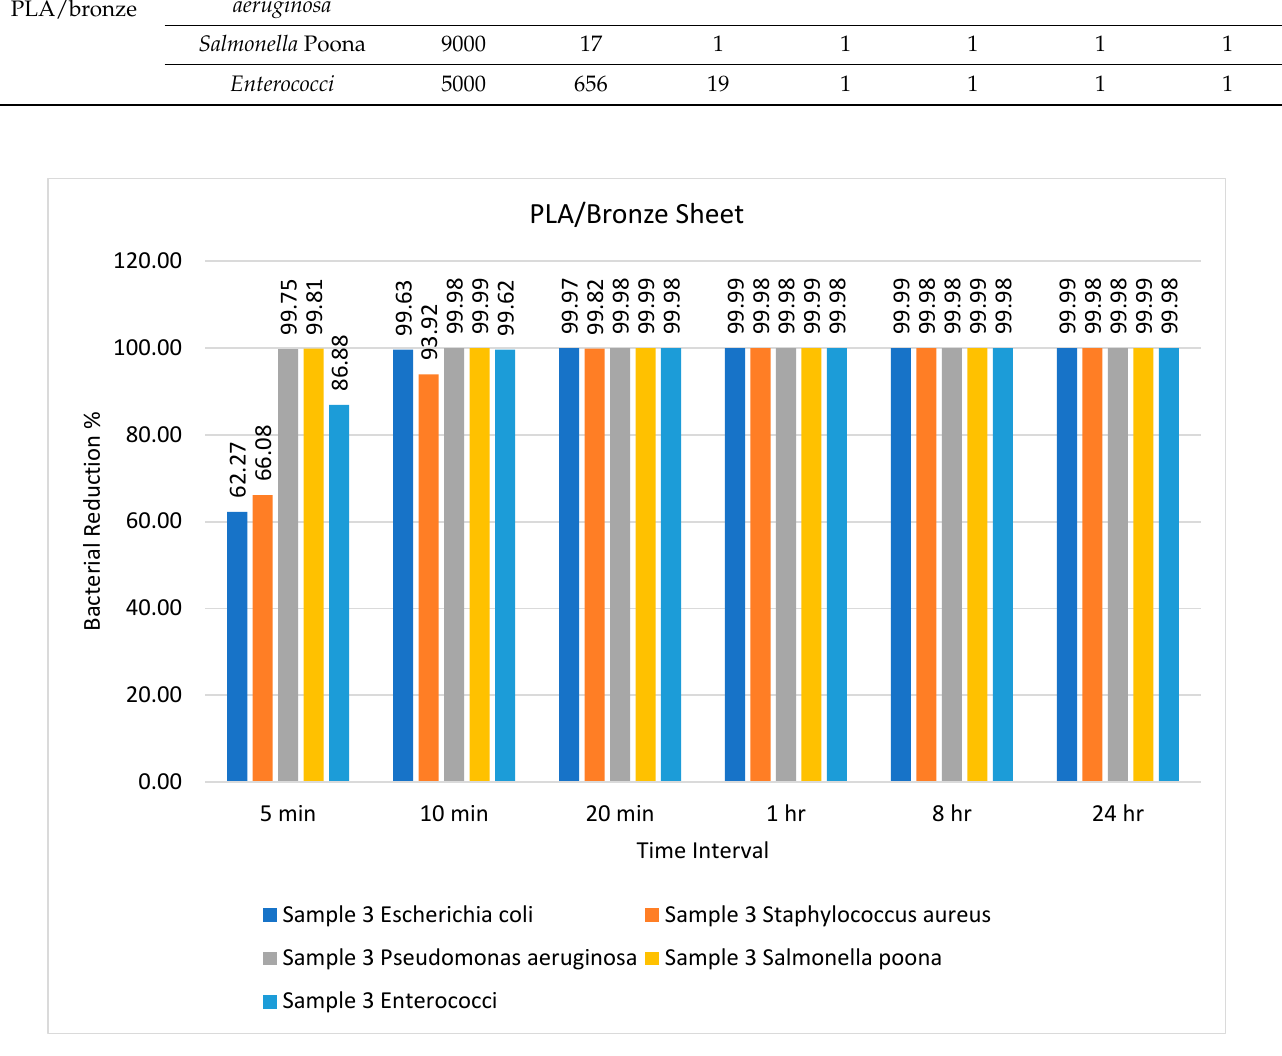
Figure 4. Percentage bacterial reduction for PLA/bronze sheet over different time